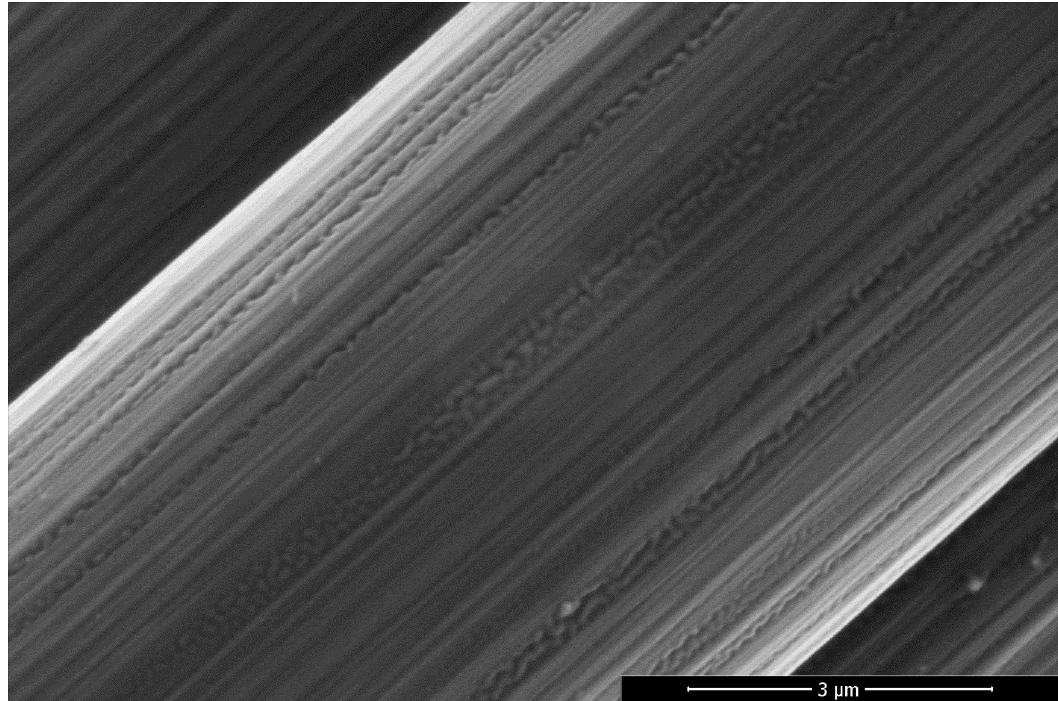
Figure 3. Scanning electron micrographs taken from the untreated reference fiber sample ( A ) and